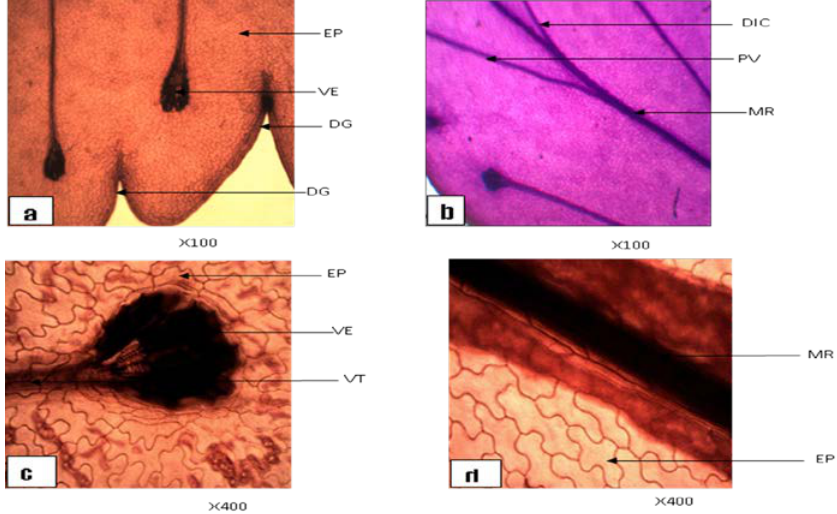
Fig. 4. Venation pattern of the leaflet of N . furcans DIC- dichotomously branched vein; MR- mid-rib; PV- primary vein; SV- secondary vein;TR- trichome; VE- vein ending in hydathode/sori;VI- vein; VT- veinlet; EP- epidermal cell; DG- deep groove at the margin;ST-